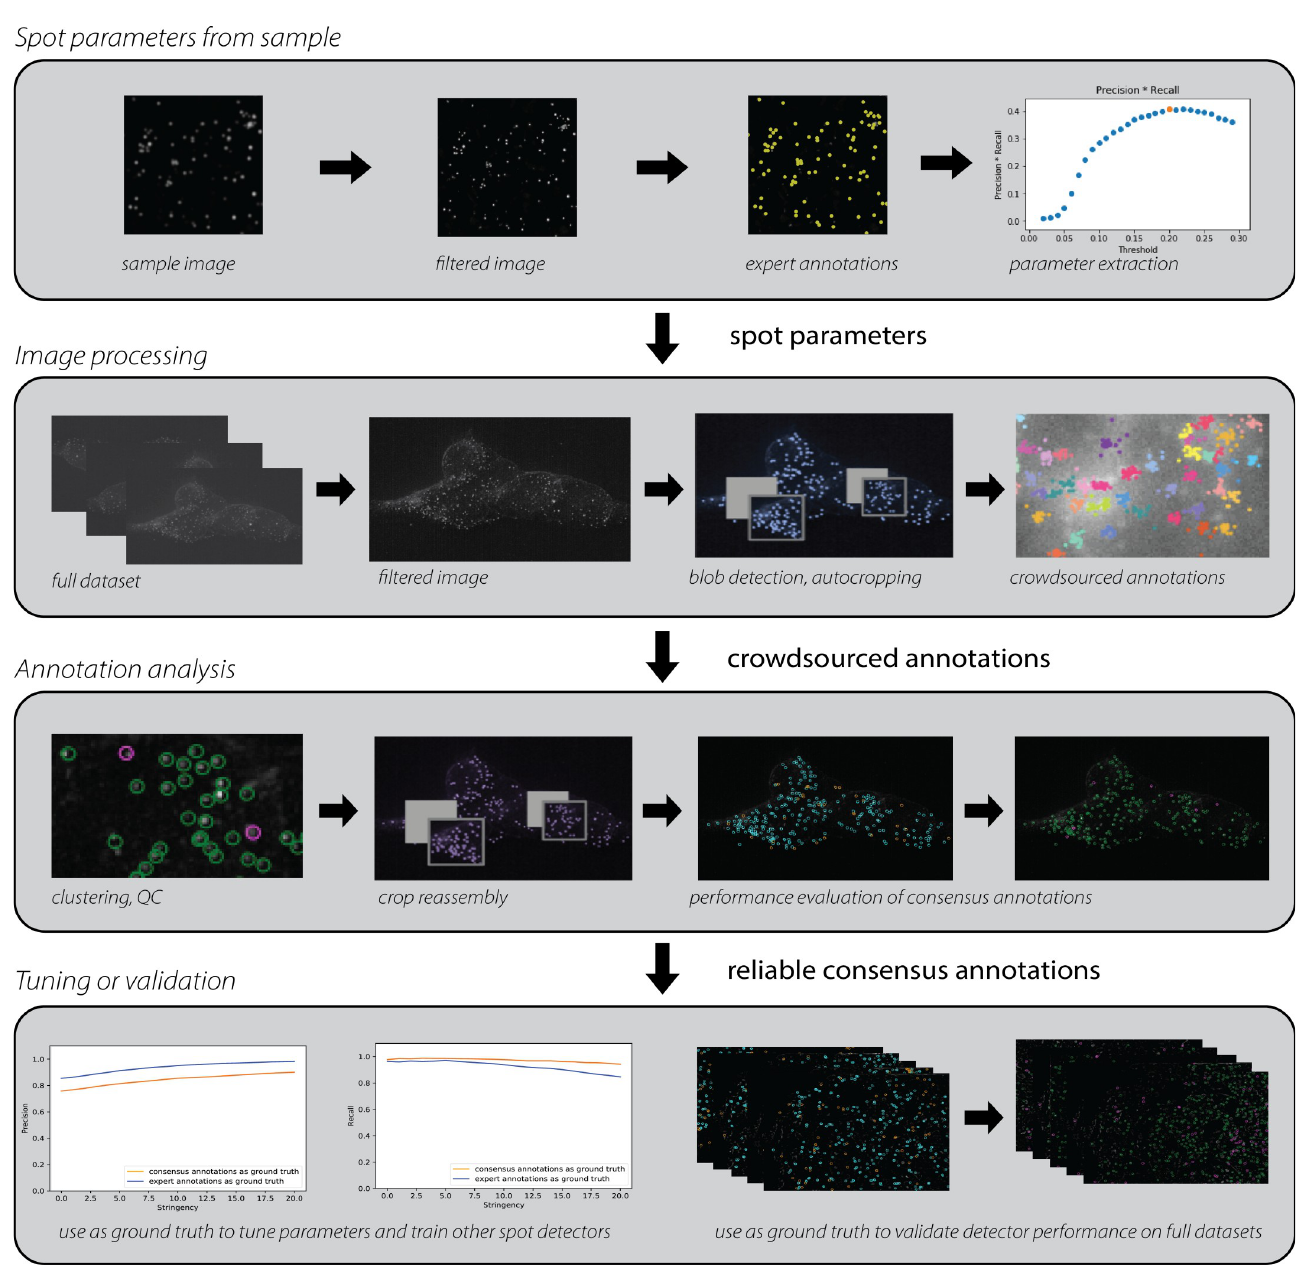
Fig 1. INSTA (IN situ Sequencing and Transcriptomics Annotation) is a pipeline for tuning and validating spot detection methods using crowdsourced annotations. The steps for optimizing the spot detection parameters specific to a given chemistry are as follows. Row 1: A sample image from that chemistry is filtered and annotated by an expert. From this small amount of expert input, the tool learns what a spot in this chemistry should look like and passes these parameters to a spot detector. Row 2: The images that will receive consensus annotations are individually pre-processed. The spot detector uses the learned parameters to do rough, first-pass spot-calling. A function then detects the crowded regions and recursively zooms in to them until the sub-images are sufficiently uncrowded that a human worker should easily be able to click on all the spots without getting fatigued. Then, all the sub-images and parent images are sent to Quanti.us, which is a system for crowdsourced annotation through Amazon’s Mechanical Turk platform. Crowdsourced workers annotate each crop. Row 3: Quality control is performed based on characteristics of the spots and clusters to produce consensus annotations, which are then reassembled to produce an original image that has been annotated with high precision and recall. Row 4: These annotations can be used to tune and train other spot detectors. They can also be used to quantify the performance of the spot detector that this run of the pipeline attempted to optimize.